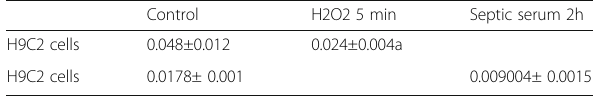
Table 2 (abstract 0129). See text for description